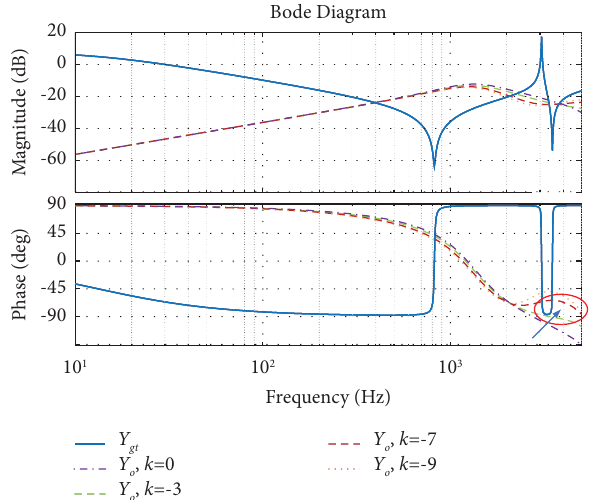
Figure 8: Te output admittance Y o ( s ) with diferent HPF feedback coefcients and the equivalent network admittance Y gt ( s ). Figure 10: Te output admittance Y o ( s ) without feedback and the equivalent network admittance Y gt ( s ) when L g � 0 and C g � 0.